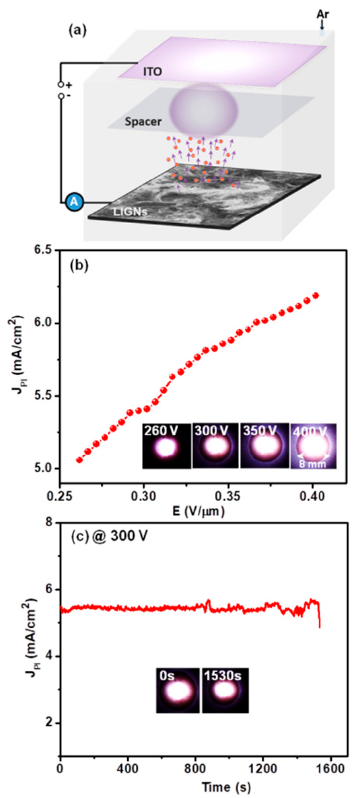
Figure 5. ( a ) Schematic of the plasma display device. ( b ) The plasma current density ( J PI ) versus applied field ( E ) of a plasma display device. Inset of ( b ) shows the photographs of plasma illumination characteristics of the plasma display device at varying voltages. ( c ) The plasma illumination stability of the LIGNs at an applied voltage of 300 V, displaying the plasma illumination intensity at 0 s and 1530 s after ignition of plasma (inset of ( c )).